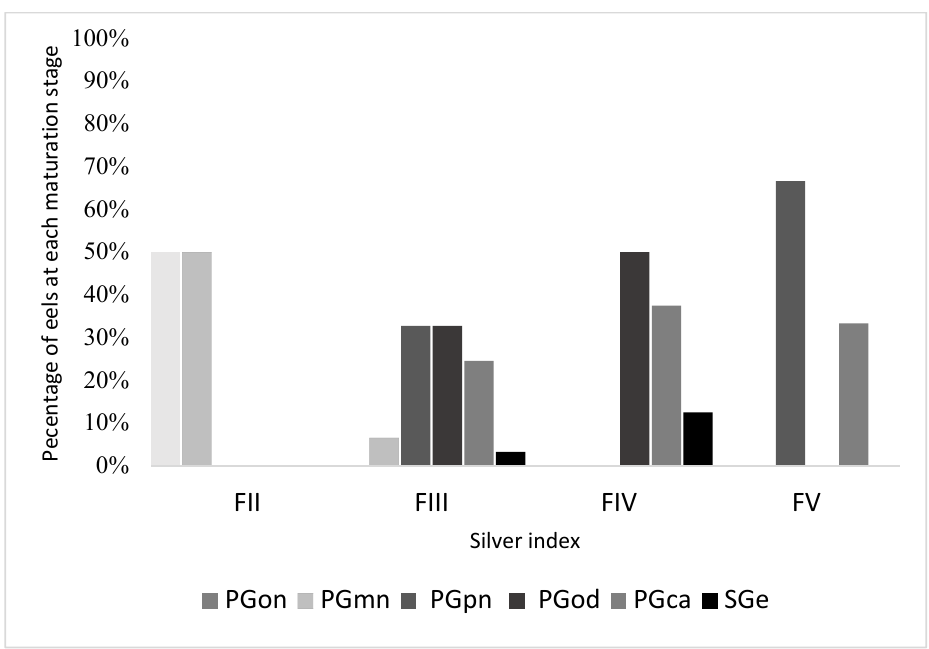
Figure 4. Percentage of eels at each oocyte maturation stage, at different stages of silvering of the sampled eels. PGon = one-nucleoli stage, PGmn = multiple nucleoli stage, PGpn = perinuclear stage, PGod = circumnuclear oil droplet stage, PGca = cortical stage, SGe = early secondary growth stage.